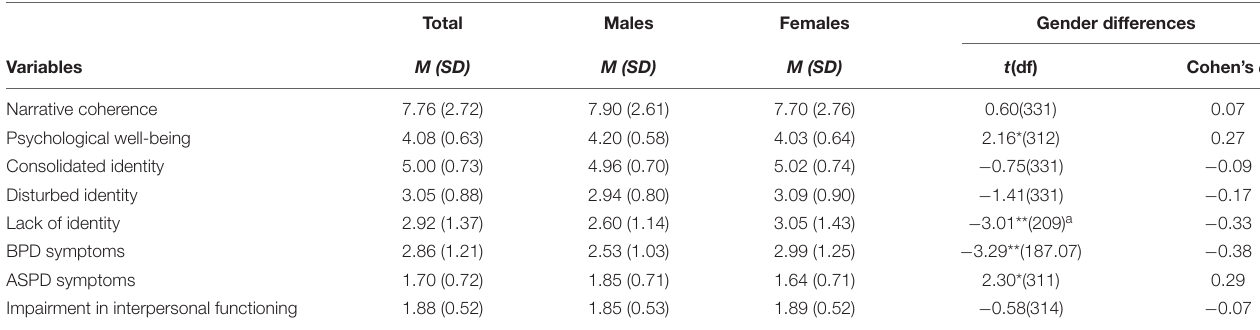
TABLE 1 | Descriptive information.